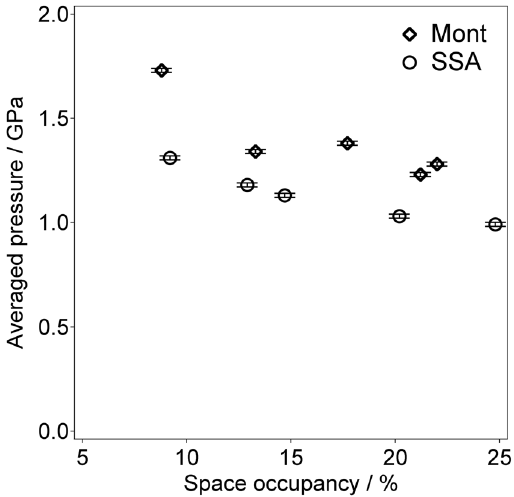
Figure 2. Dependence of averaged pressure on space occupancy of BP in SSA or Mont interlayer space. Diamonds and circles indicate results for hybrid films with Mont and SSA, respectively.